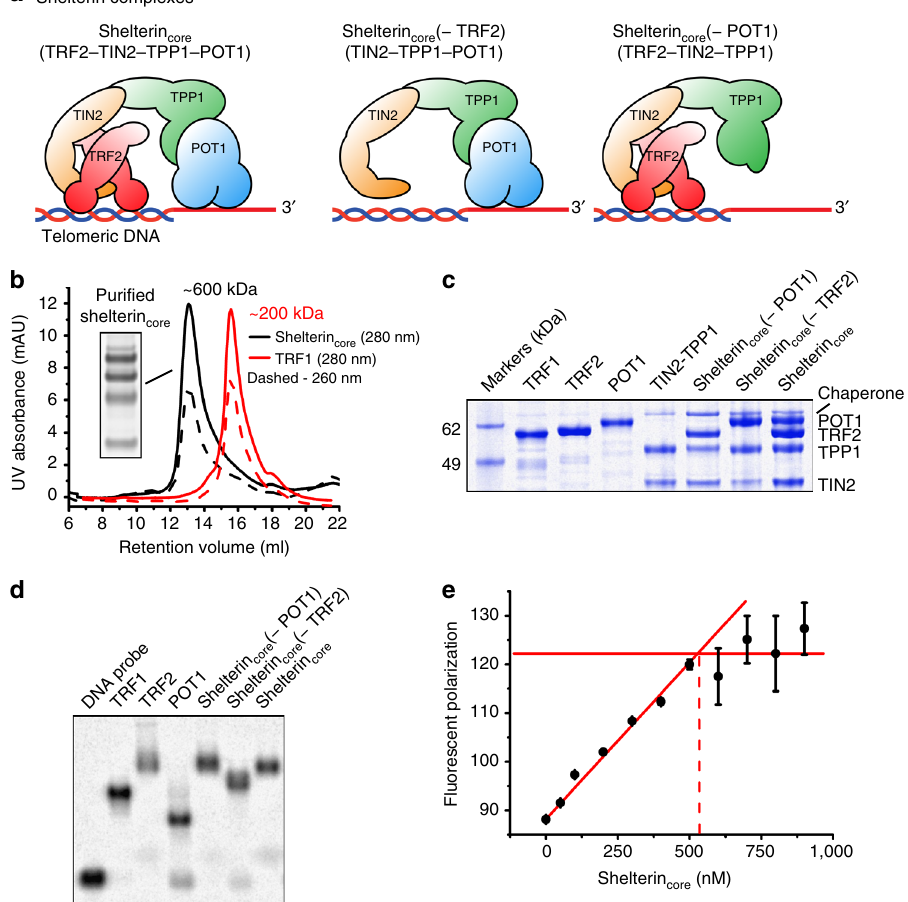
Fig. 1 Human shelterin proteins form stable protein and DNA – protein complexes in vitro. a Cartoon schematics of shelterin complexes reconstituted in this work. b Representative size-exclusion chromatography trace of puri fi ed shelterin core complex using Superose 6 10/300 increase column. The trace of TRF1 is included for comparison. c SDS-PAGE of puri fi ed recombinant human shelterin complexes expressed and reconstituted in Tni insect cells. Soluble puri fi ed individual shelterin subunits TRF1, TRF2, and POT1 are shown for comparison. The band above POT1 was identi fi ed via mass spectrometry to be the HSP70 chaperone. SDS-PAGE (sodium dodecyl sulfate-polyacrylamide gel electrophoresis) is visualized with Coomassie blue stain. d Agarose-EMSA shows stable protein – DNA complexes formed by recombinant human shelterin complexes containing TRF2, POT1, or both with ss/ds telomeric DNA substrate (C8). The telomeric ss/ds DNA substrate is 32 P-5 ′ -labeled (longer strand) and incubated with 500 nM protein for 30 min at room temperature before running on a 0.5% agarose gel. The experiments in b – d were repeated twice (independent experiments) to ensure consistency. e Saturation-binding assay to determine shelterin core complex DNA-binding activity. 500 nM Alexa-488-5 ′ -labeled C8 substrate was used in a fl uorescent polarization assay with increasing shelterin core concentration. Red lines are drawn for ease of visualization. (Error bars indicate range of data, n = 2 independent